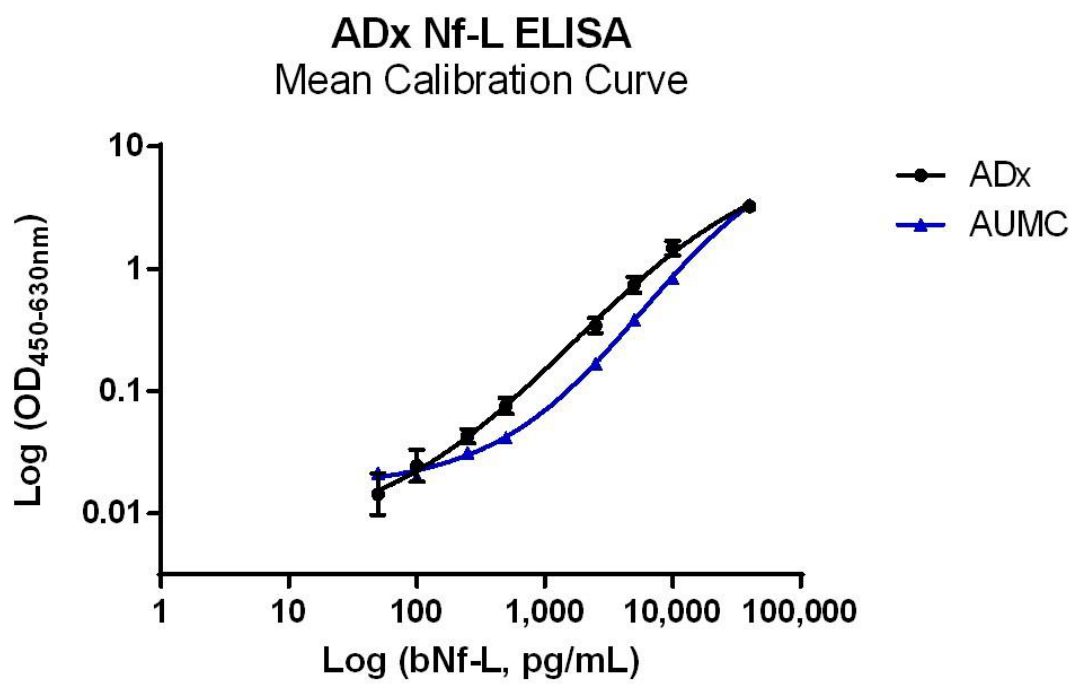
Figure 3. Mean calibration curve of full-length bNf-L in the ADx Nf-L ELISA determined at ADx and at AUMC. The calibrator curve has been fitted using a log-transformed, sigmoidal, unweighted 4PL curve fit. An analytical range of 40,000 pg/mL to 50 pg/mL was used.